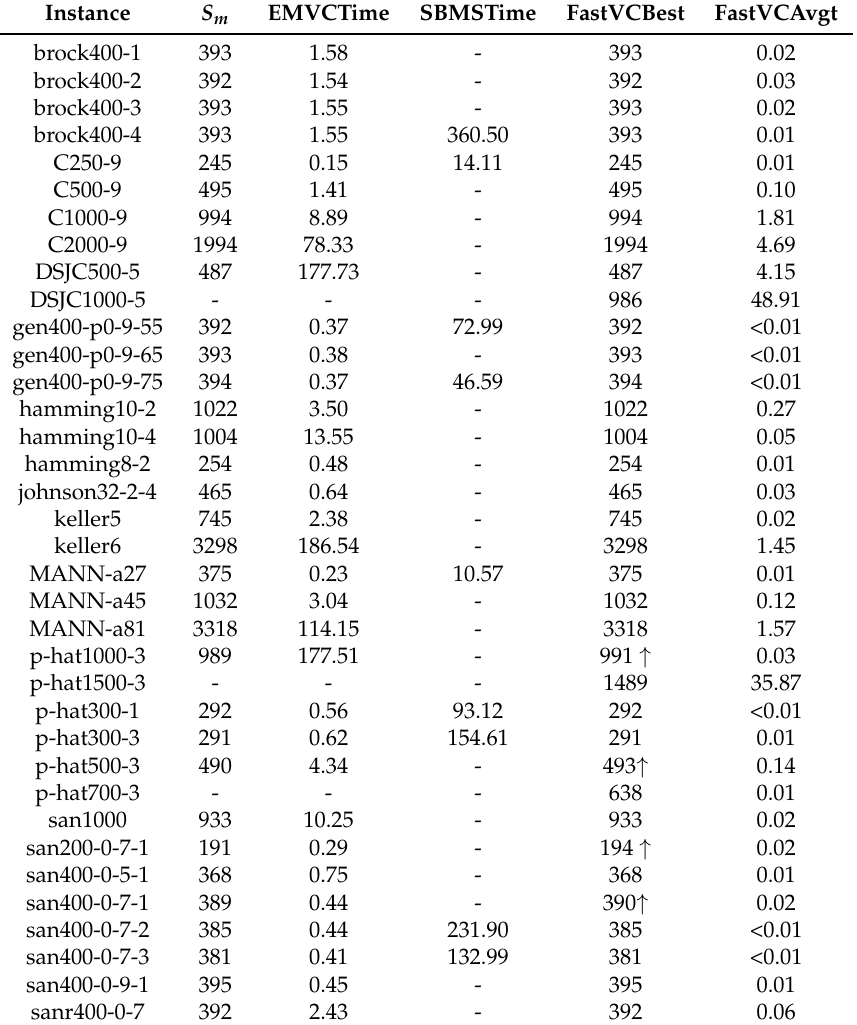
Table 1. Comparison with different